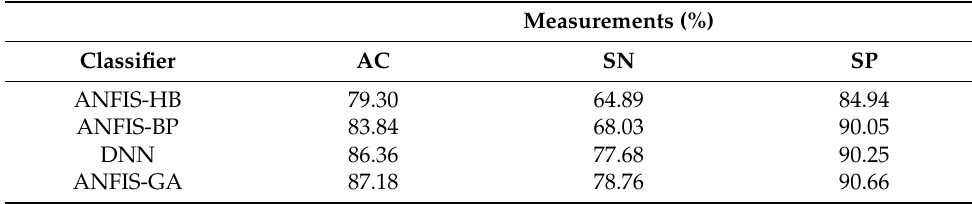
Table 5. The average performance criteria for all